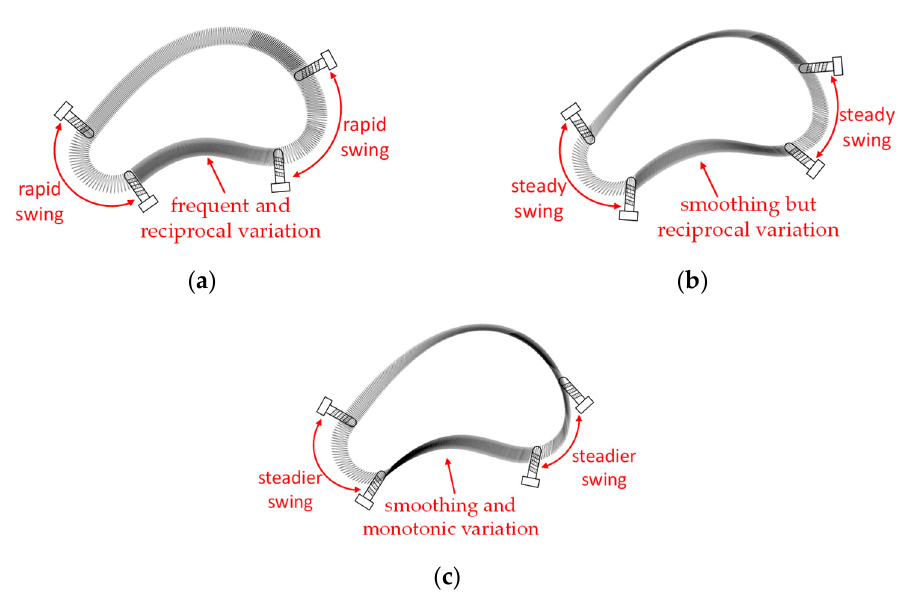
Figure 15. Comparison of tool orientation based on different methods. ( a ) Original tool orientation; ( b ) tool orientation scheduled by the compared method; ( c ) tool orientation scheduled by the proposed method.